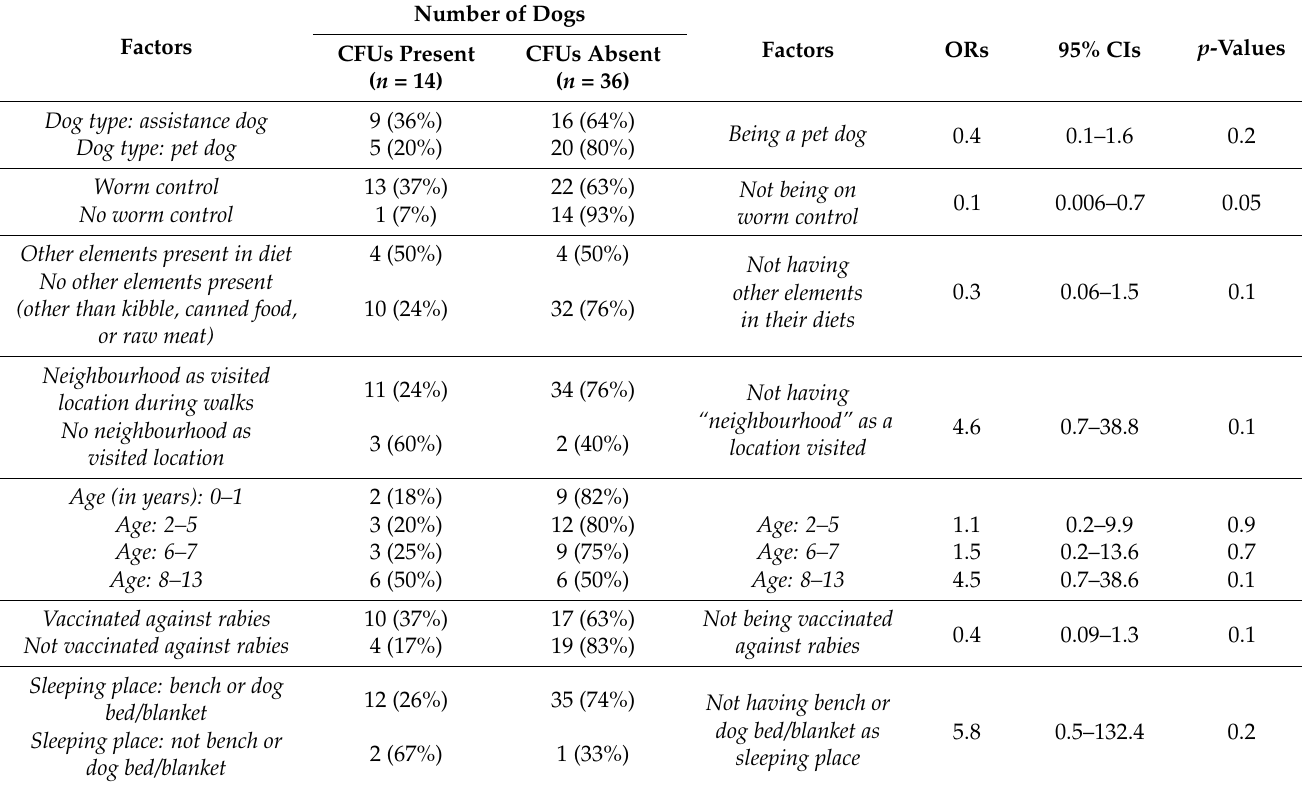
Table 4. Unadjusted odds ratios (ORs) and their 95% confidence intervals (95% CIs) for the possible factors in the univariable models with p -values < 0.25, linked to the presence or absence of colony-forming units (CFUs) of the Enterobacteriaceae family, recovered from dog paws.